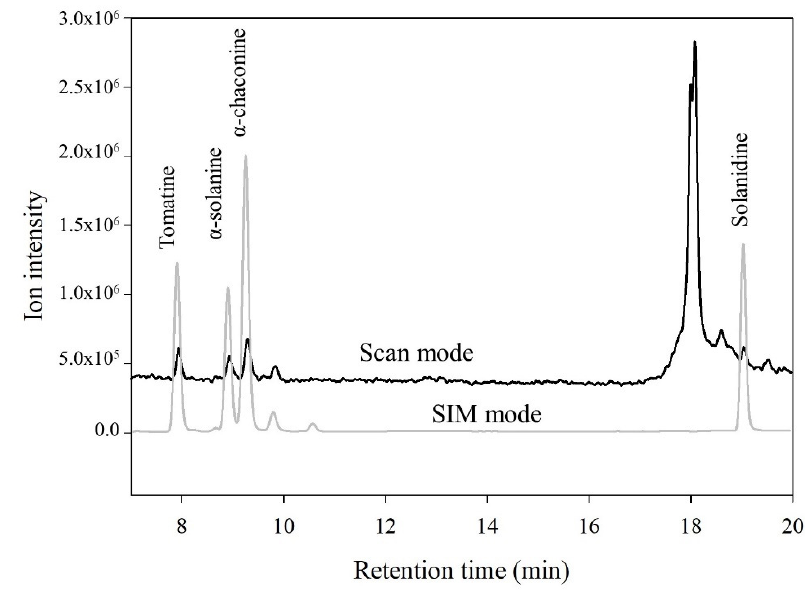
Figure 4. Identification of potato glycoalkaloids in food-grade potato protein powder by LC–ESI/MS in scan mode and single ion monitoring (SIM) mode.